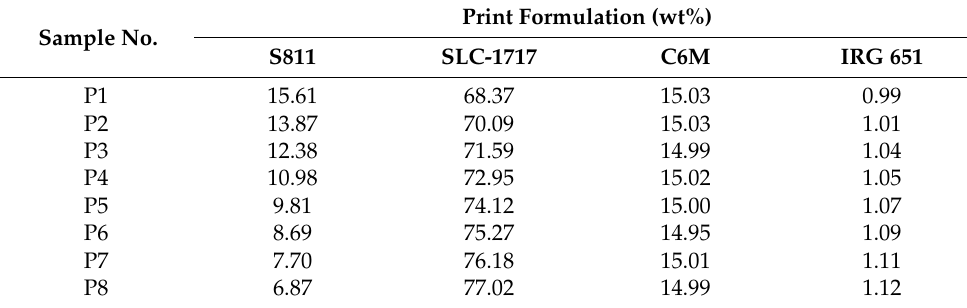
Table 2. Composition of the hand mixed Ch-LC mixtures. Sample